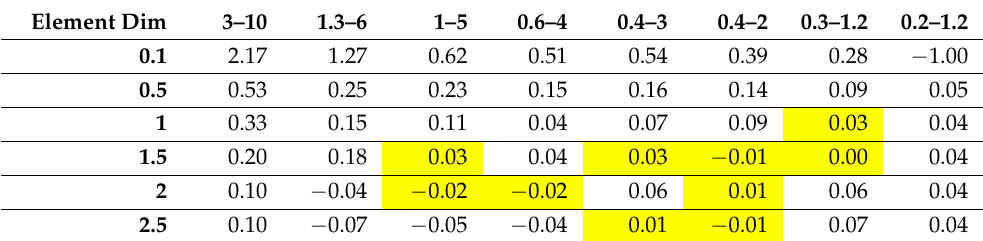
Table 9. The comparison between the dimension of the element of the superficial meshes and the volumetric element in FEA for the triangular simplified models. The column represents the dimen- sion of the superficial mesh element, and the rows represent the dimension of the volumetric ele- ments in the FEA software.